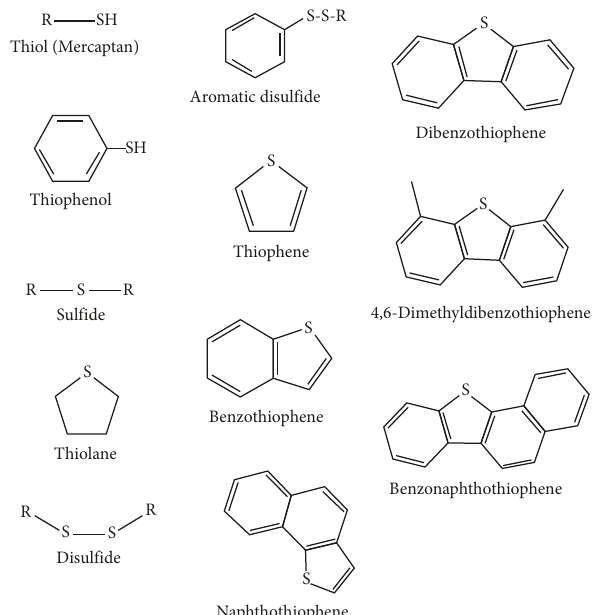
Figure 1: Common organic sulfur compounds in crude oil (taken from [1,